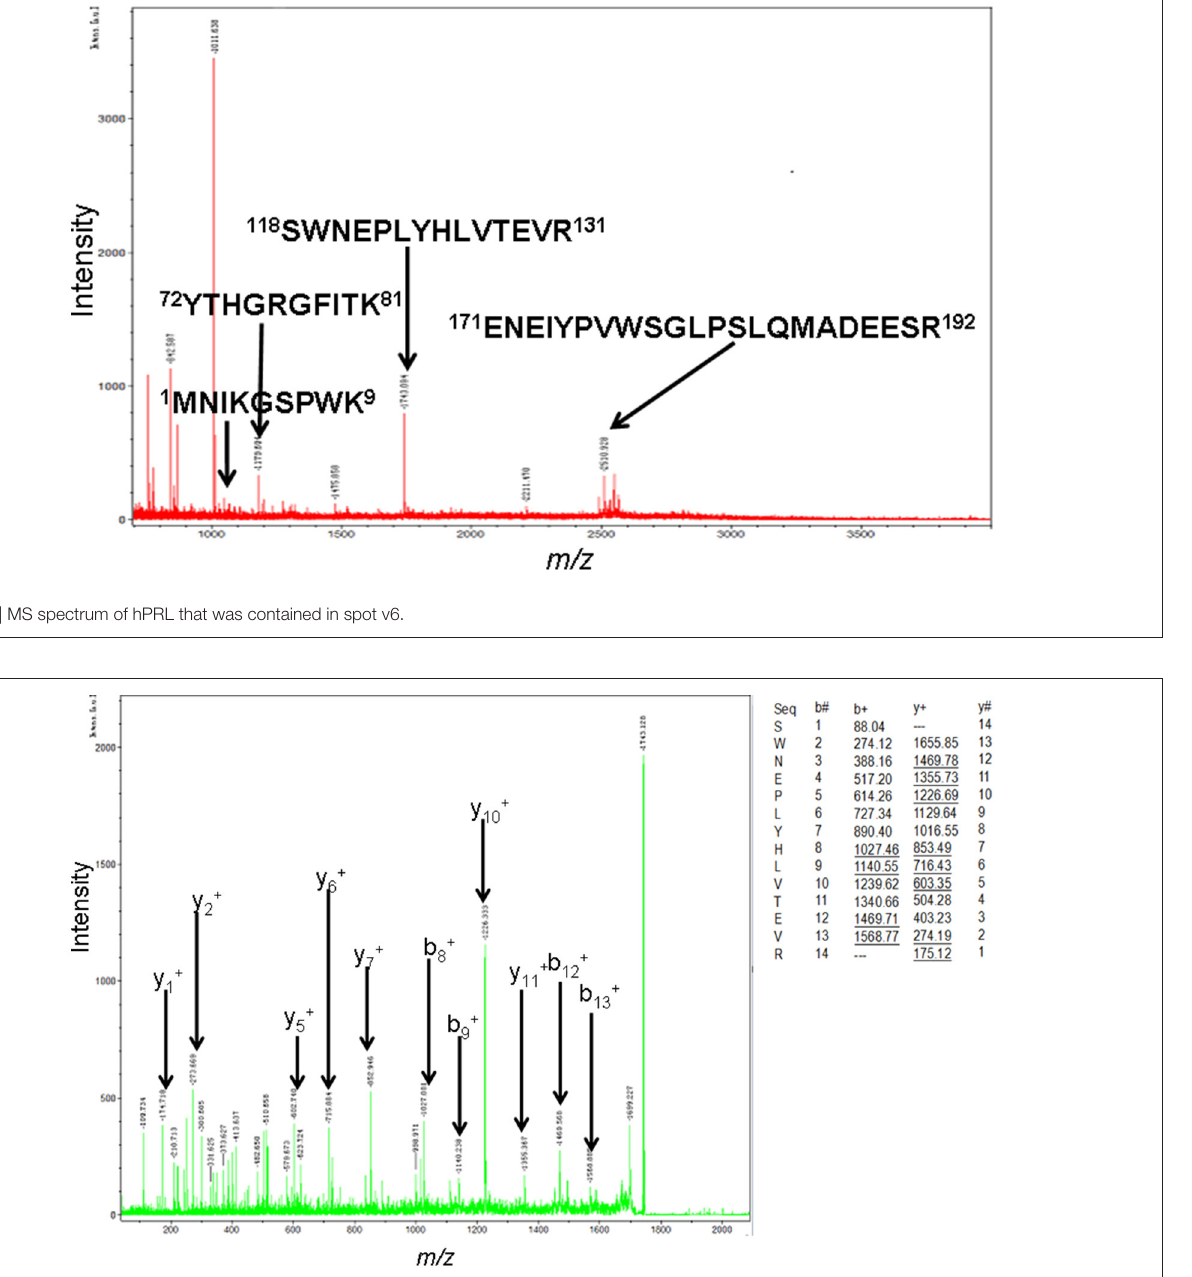
Western blot-immunopositive reaction ( Figure 5 ). Furthermore, the protein in each immunopositive spot (v1, v4, v5, and v6) was identified as PRL (Swiss-Prot No. P01236) with MALDI- TOF-MS PMF data and MALDI-TOF-TOF MS/MS. The PMF data (calculated; observed) of those four validated hPRL variants are collected in Table 4 . Two tryptic peptides were obtained in spot v1, including 72 YTHGRGFITK 81 with a [M + H] + ion at